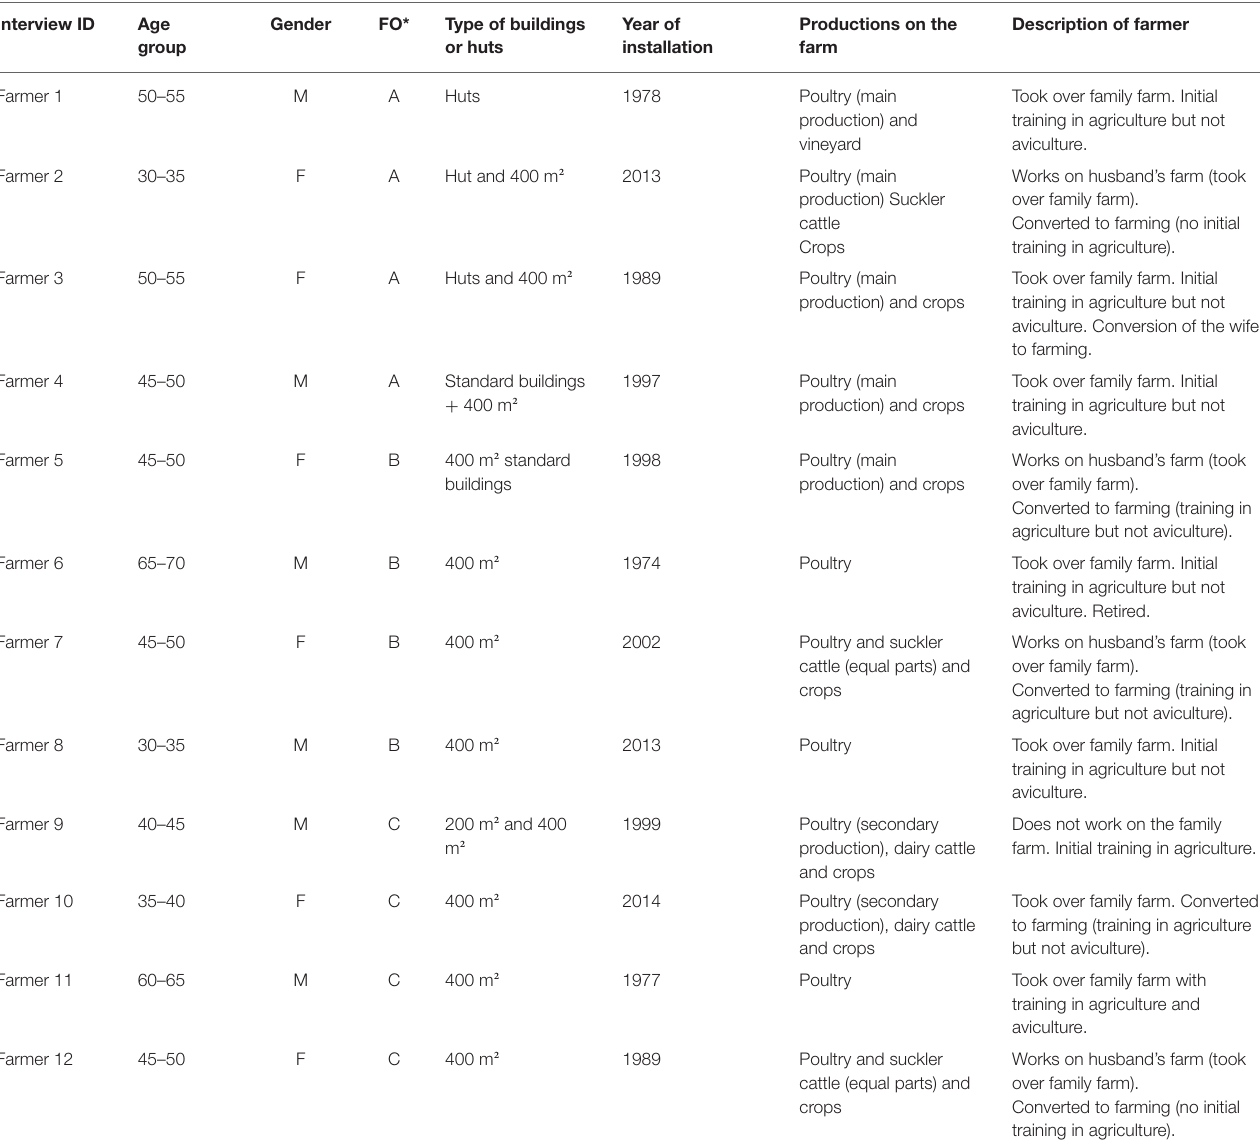
TABLE 1 | Main characteristics of the farmers